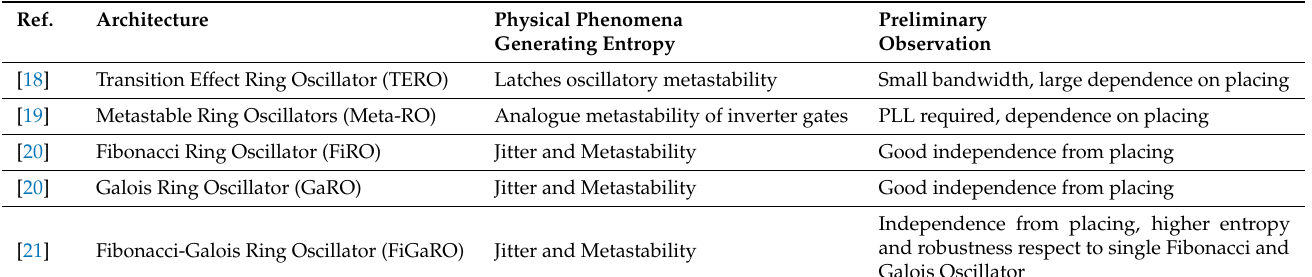
Table 1. Digital True-Random Number Generators (TRNGs) in